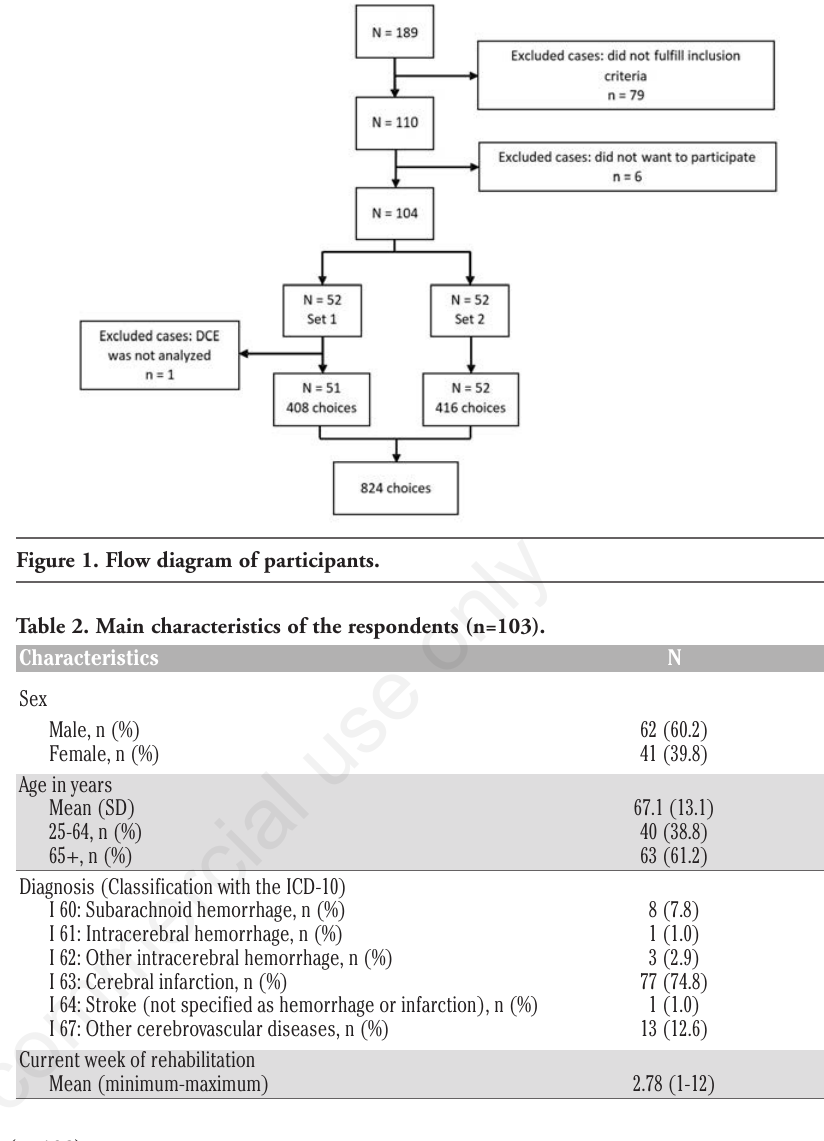
Table 3. Logit choice model for respondents (n=103).